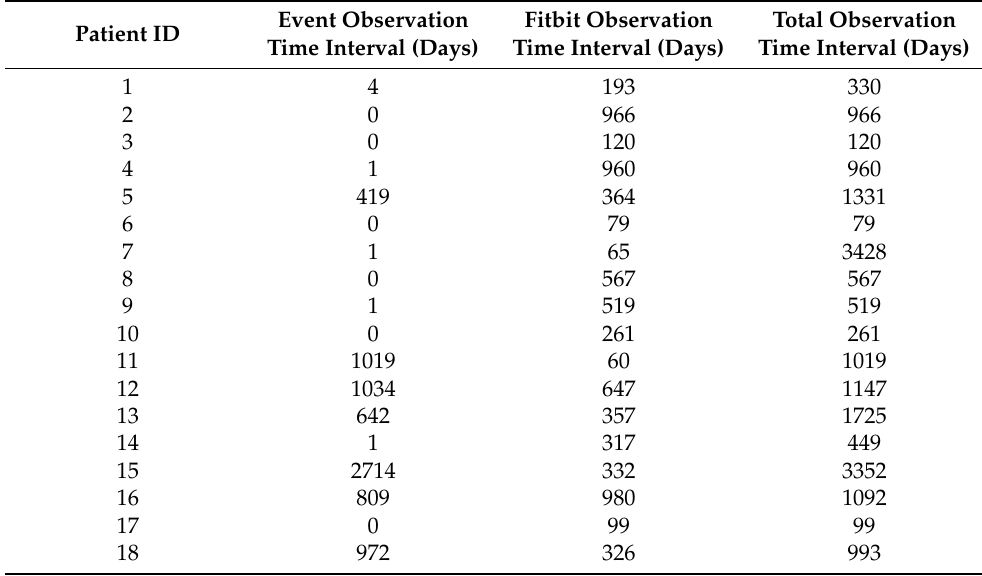
Table A2. Monitoring days for events, Fitbit, and overall (27